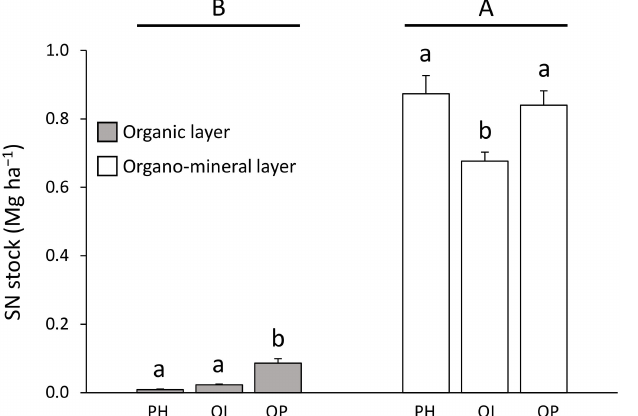
Figure 6. Soil nitrogen stock according to the significant forest type × soil layer interaction (Table 2). Data are mean values ± SE and expressed as Mg per ha; n = 30. Different capital letters denote significant differences between soil layers with A > B (post hoc Tukey tests results). Different lowercase letters denote significant differences between forest types for each soil layer with a > b > c (post hoc Tukey tests results). SN—soil nitrogen, PH— Pinus halepensis , QI— Quercus ilex , QP— Quercus pubescens